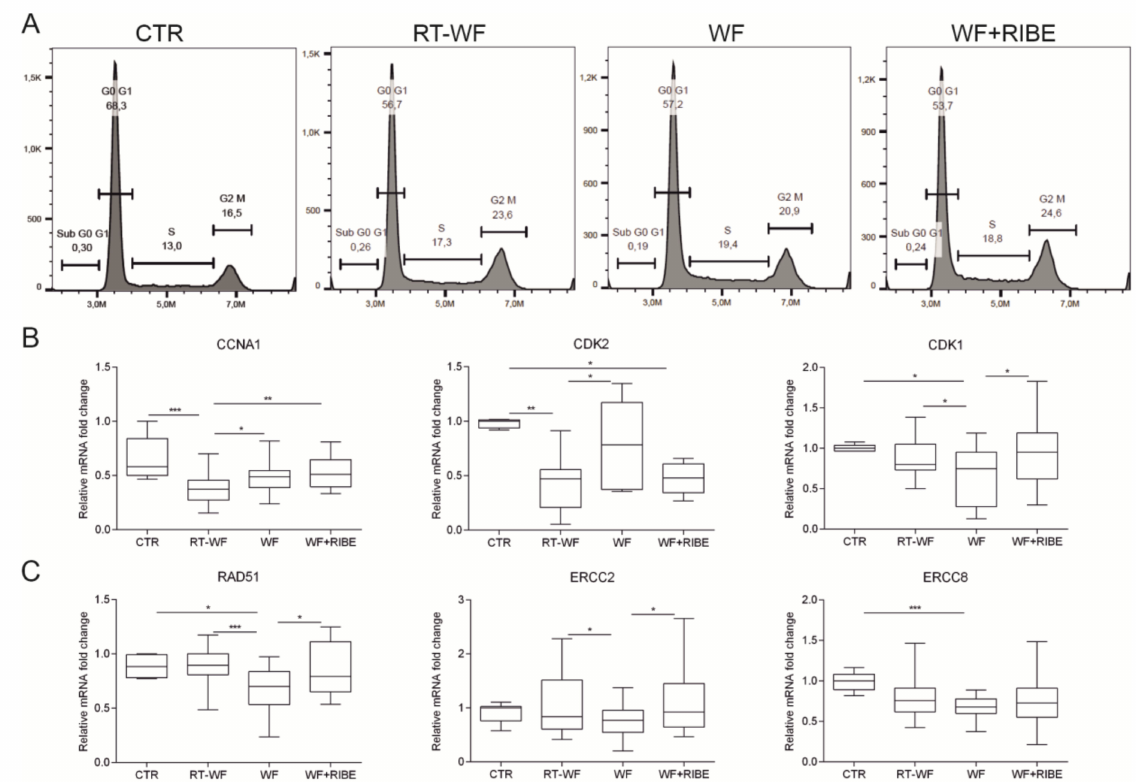
Figure 3. Surgical wound fluids a ff ect the cell cycle and DNA damage response of the MDA-MB-468 cell line. MDA-MB-468 cell lines were incubated with WF, RT-WF, and WF + RIBE fluids for two